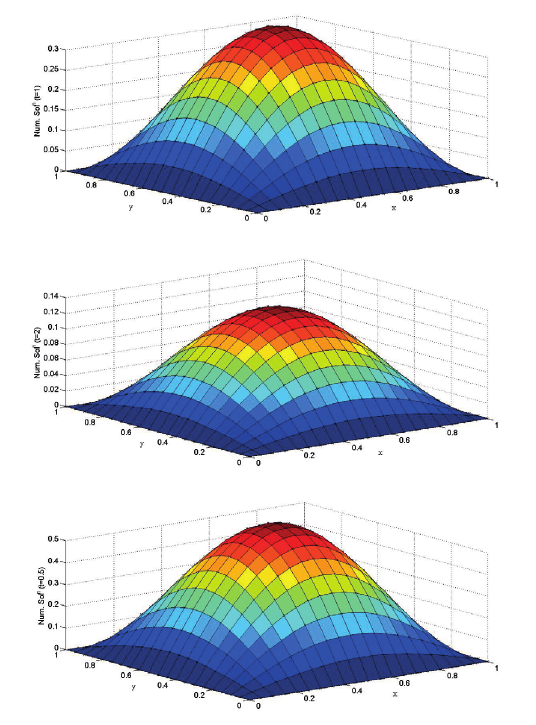
Fig. 6: Plots of numerical solution at different time levels for Exam- ple 5.5